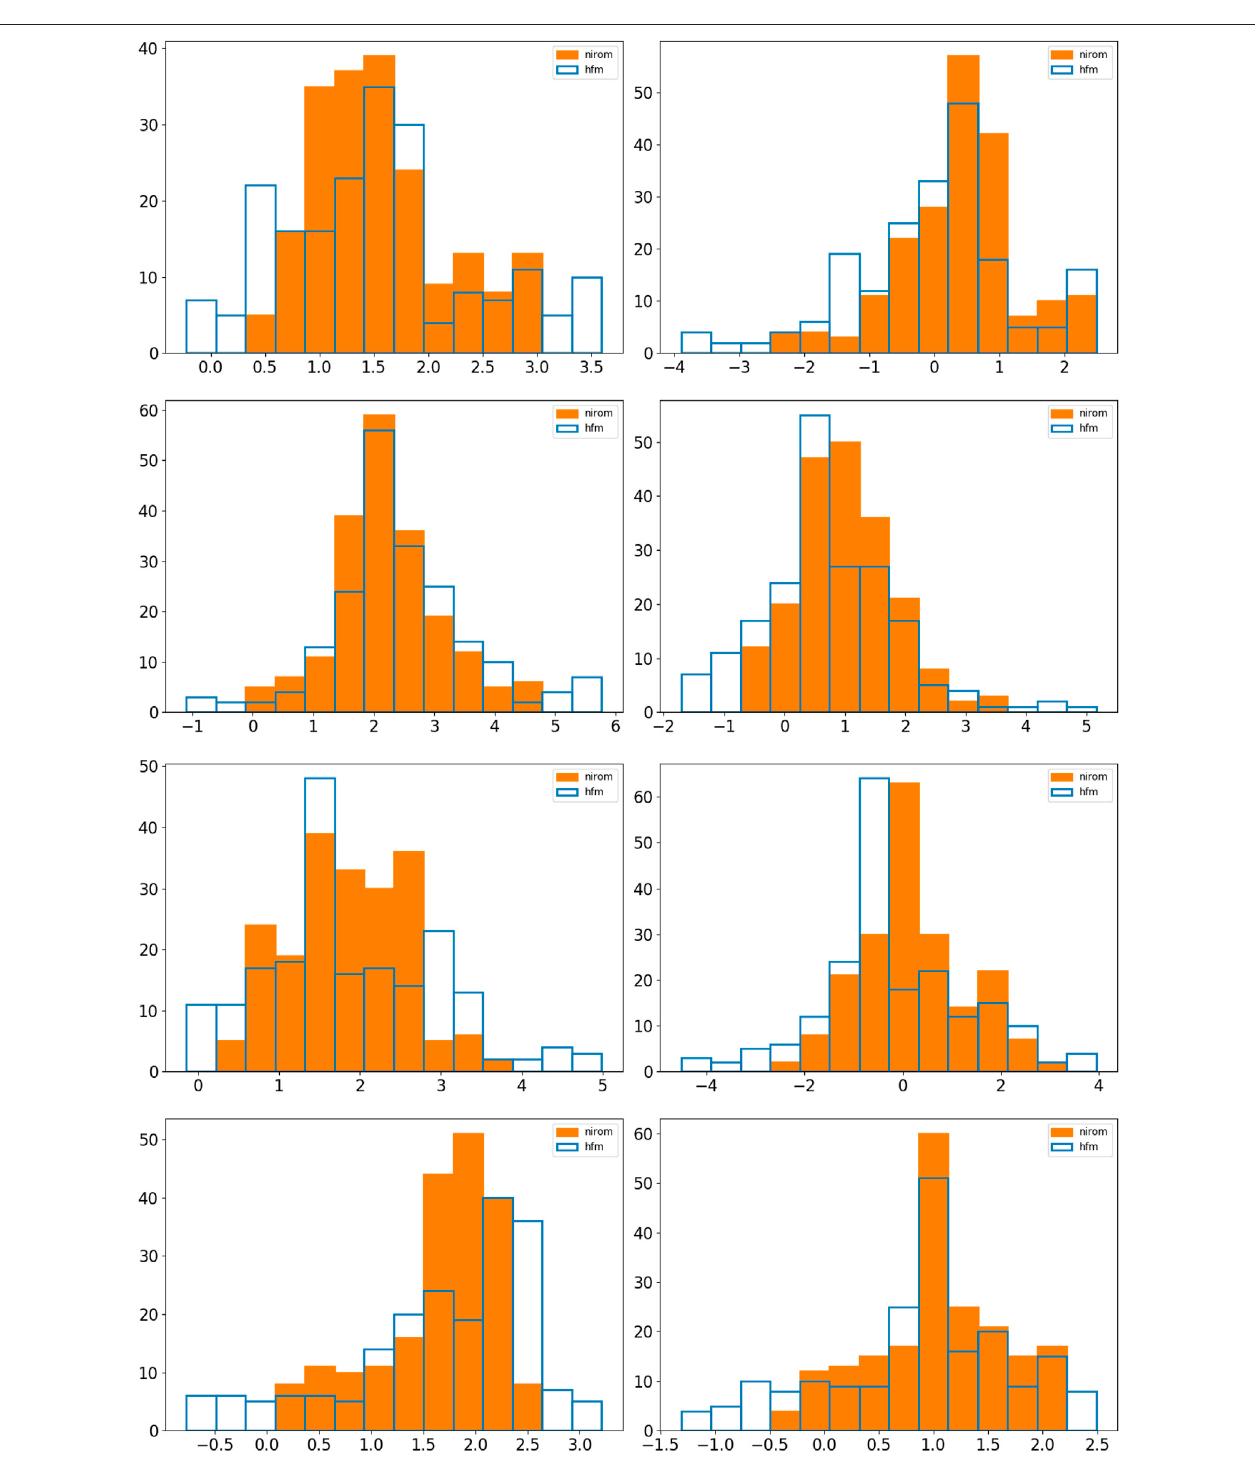
FIGURE 12 | Here we show histograms for the 9 by 9 test case at points 1, 2, 3 and 4 (see Table 3 ) in rows from top to bottom respectively. The fi rst column of graphs show the x − component of velocity and the second the y − component. We compare in these graphs the histograms (or probability density functions) of the velocity components of the HFM (not seen in training), blue, and the prediction from NIROM in orange.